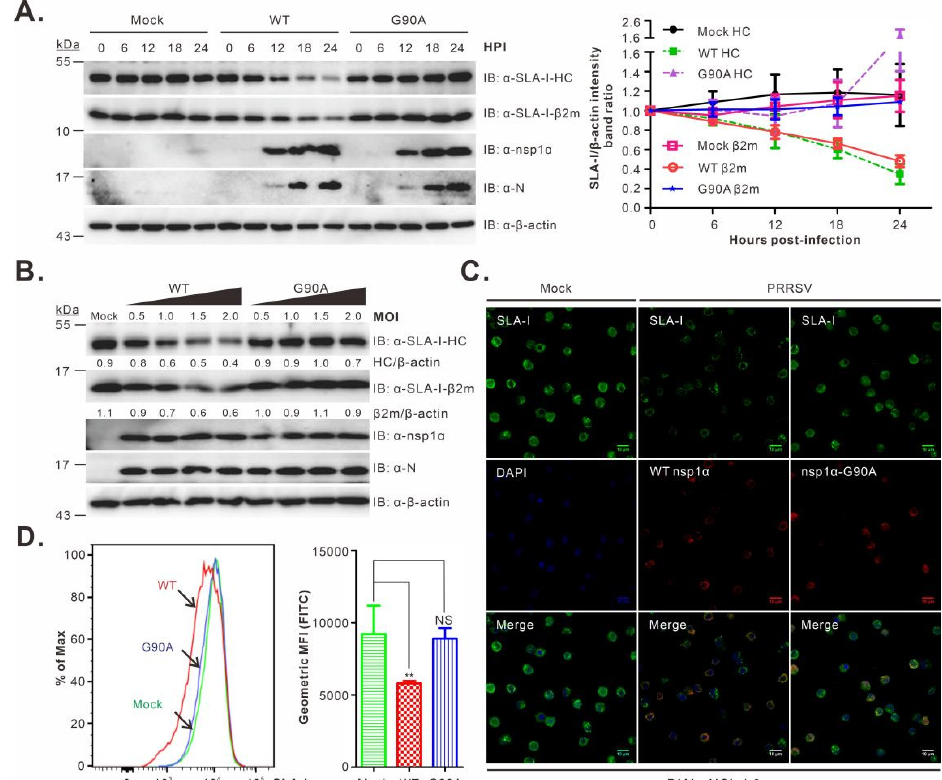
Figure 5. Effect of the nsp1 α -G90A mutation on the SLA-I accumulation in virus-infected PAMs. ( A ) PAMs were either mock-infected with RPMI 1640 or infected with rescued viruses WT or the mutant G90A at an MOI of 1.0. At the indicated time points, PAMs were harvested and subject to Western blot analysis using the indicated antibodies. The right graph shows the quantitative analysis of SLA-I abundance measured by the band intensity ratio of SLA-I-HC/ β 2m over β -actin. ( B ) The same as ( A ), except that different doses were used and that the Western blot analysis was performed at 12 h post-infection. ( C ) The same as ( A ), except that the cells were fixed for IFA analysis at 12 h post-infection with antibodies to SLA-I (JM1E3) and nsp1 α . DAPI was used to stain cell nuclei. ( D ) The same as ( A ), except that at 12 h post-infection, PAMs were harvested and subjected to FACS analysis with mouse mAb to SLA-I (JM1E3). The SLA-I levels were presented as the mean fluorescence intensity (MFI) in the right panel. The data shown are the means and standard deviations from three independent experiments (** p < 0.01; NS, not